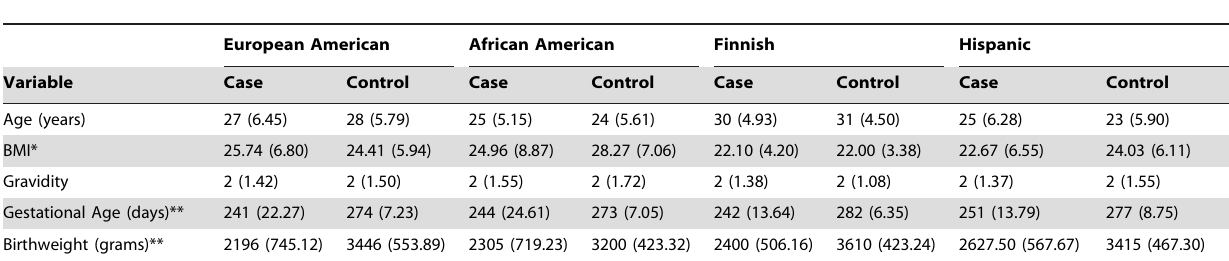
Table 2. Demographic profile of study